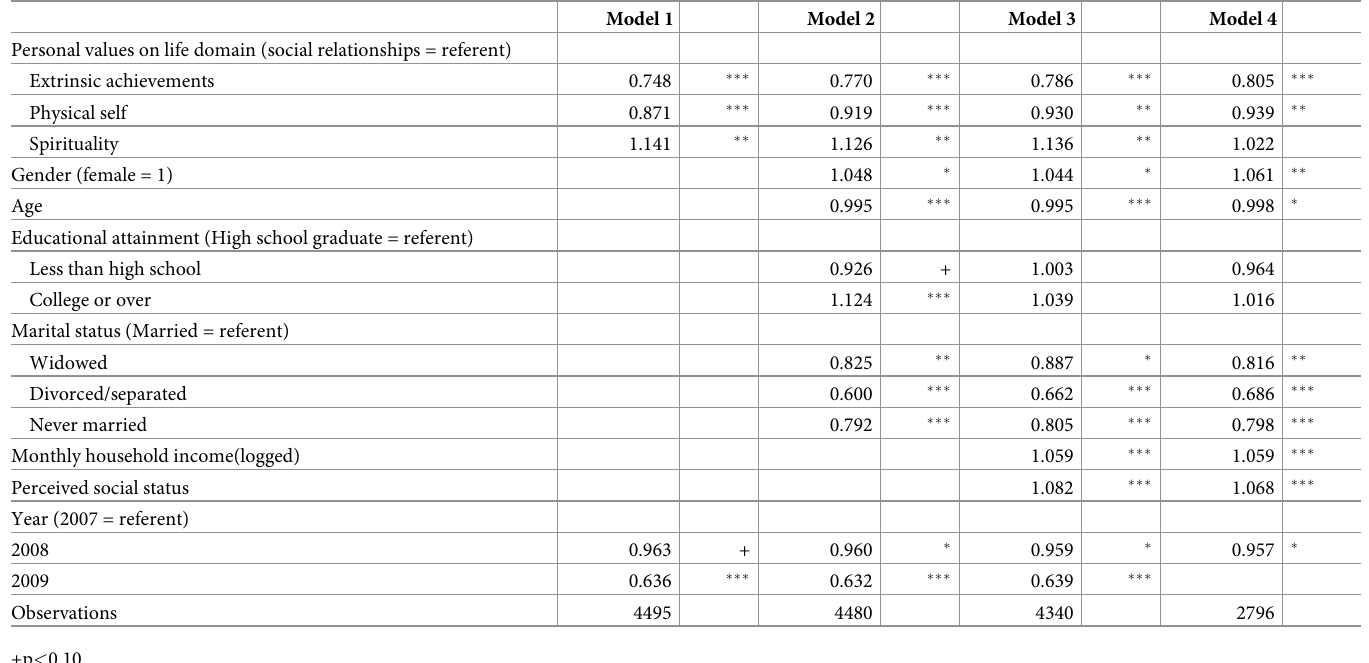
Table 3. Poisson regression analyses with robust error variances examining associations between personal values on life domains and happiness (relative